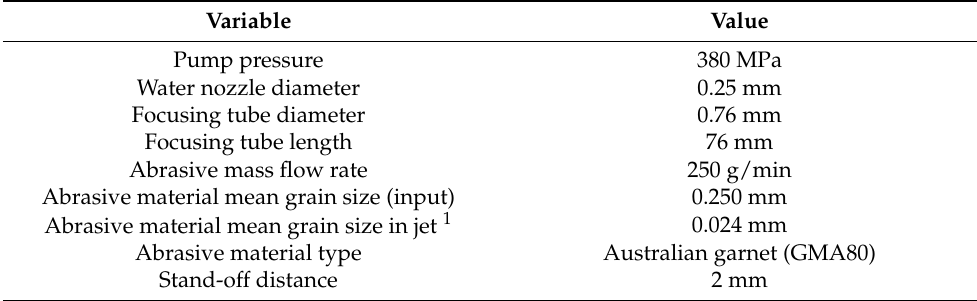
Table 3. Factors and settings applied in all